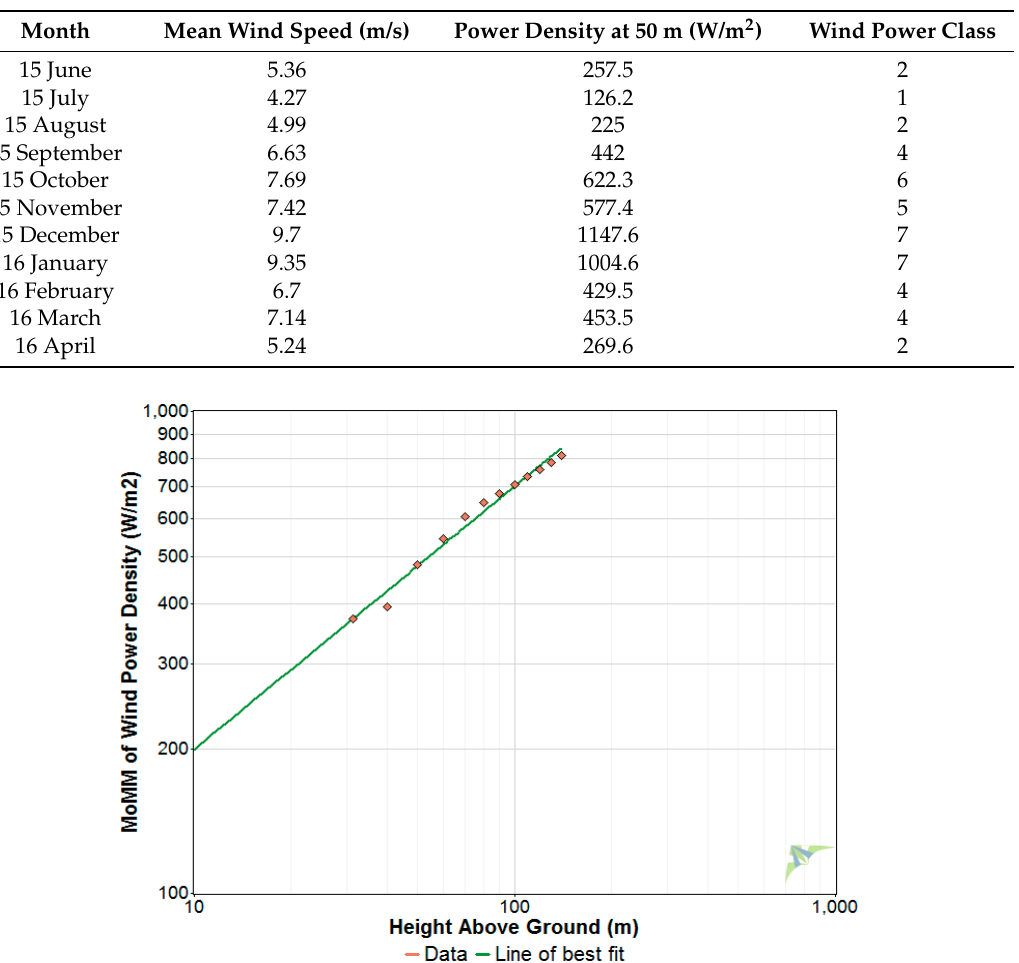
Table 3. Monthly wind power class.